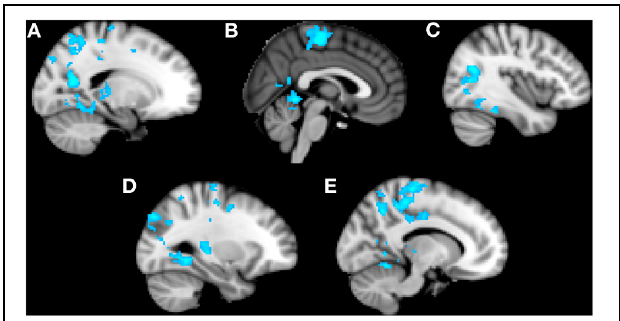
FIGURE 2 | Clusters of activity significantly correlated with trait anxiety in the Alone condition. Blue areas indicate a negative correlation with trait anxiety. (A) Cluster 1, peak activation in left precuneus. (B) Cluster 2, peak activation in precentral gyrus. (C) Cluster 3, peak activation